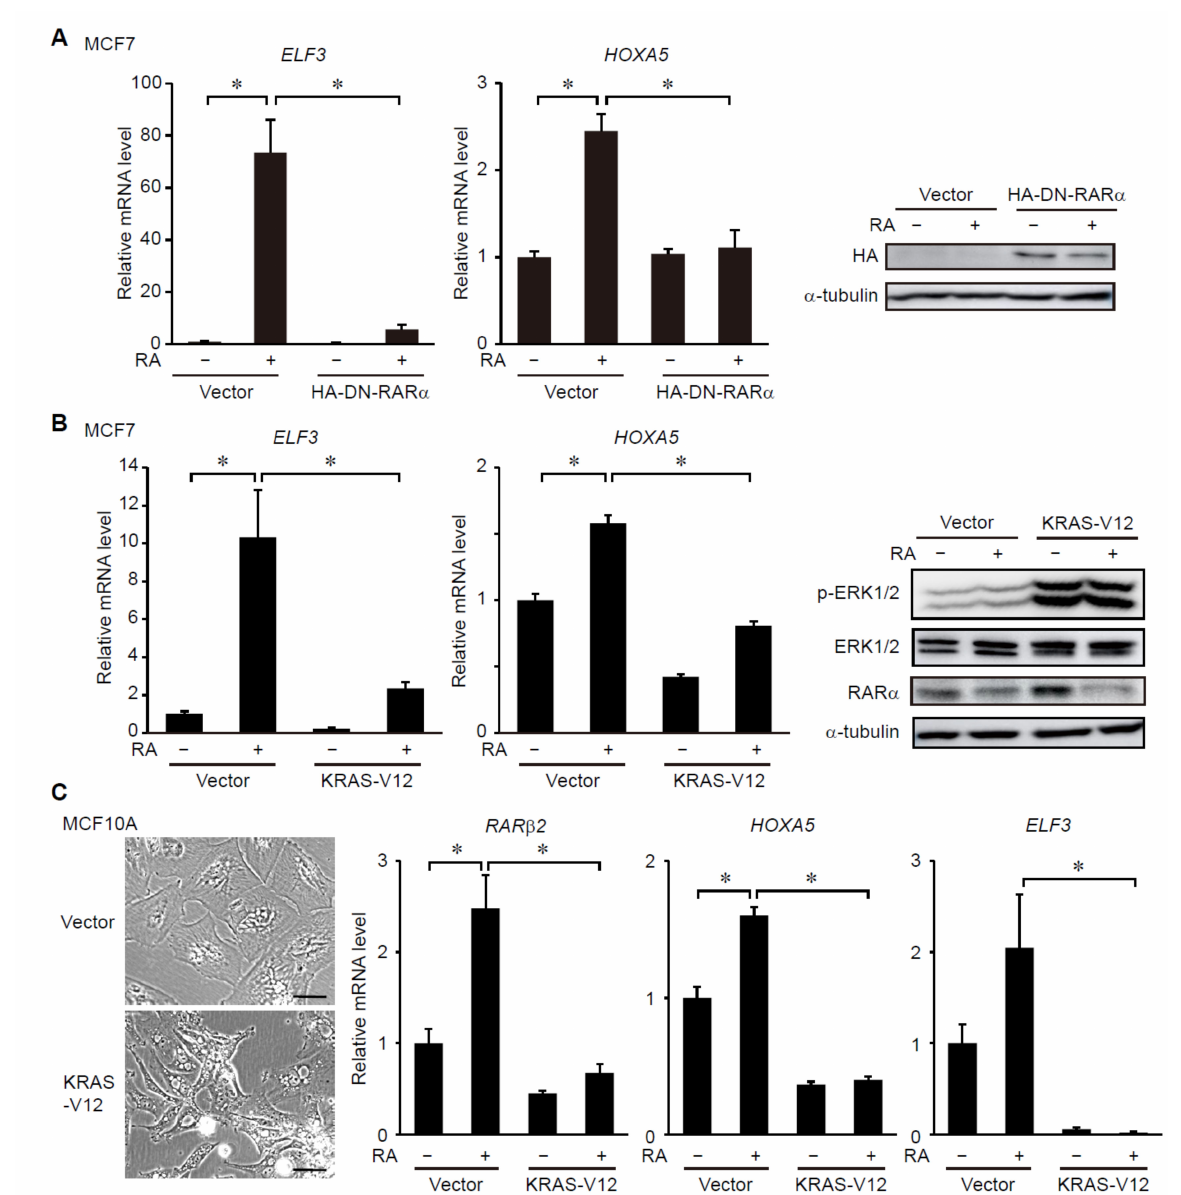
Figure 1. Ligand-dependent induction of RAR-target genes is suppressed by activation of RAS-ERK signaling. ( A ) A HA-tagged dominant negative form of RAR α (HA-DN-RAR α ) was expressed in MCF7 cells by using lentivirus. Cells were treated with DMSO or RA (1 µ M) for 24 h prior to the analyses. Total RNA and proteins were analyzed by RT-PCR (left) and immunoblotting (right), respectively. *, p < 0.05 (one-way ANOVA followed by Tukey post hoc analyses) (mean + s.e.m., n = 4). ( B ) KRAS-V12 was expressed in MCF7 cells by using lentivirus. 4 days after infection of lentivirus, cells were treated with DMSO or RA (1 µ M) for 24 h. Total RNA and proteins were analyzed by RT-PCR (left) and immunoblotting (right), respectively. *, p < 0.05 (one-way ANOVA followed by Tukey post hoc analyses) (mean + s.e.m., n = 4). ( C ) KRAS-V12 was expressed in MCF10A cells by using lentivirus. 3 days after infection of lentivirus, cells were treated with DMSO or RA (1 µ M) for 24 h. The indicated mRNA levels were analyzed by RT-PCR. (left) Morphology of MCF10A cells expressing KRAS-V12 or control cells. Scale bars: 50 µ m. *, p < 0.05 (one-way ANOVA followed by Tukey post hoc analyses) (mean + s.e.m., n = 3). Uncropped immunoblot images are shown in Supplementary Material (Figure